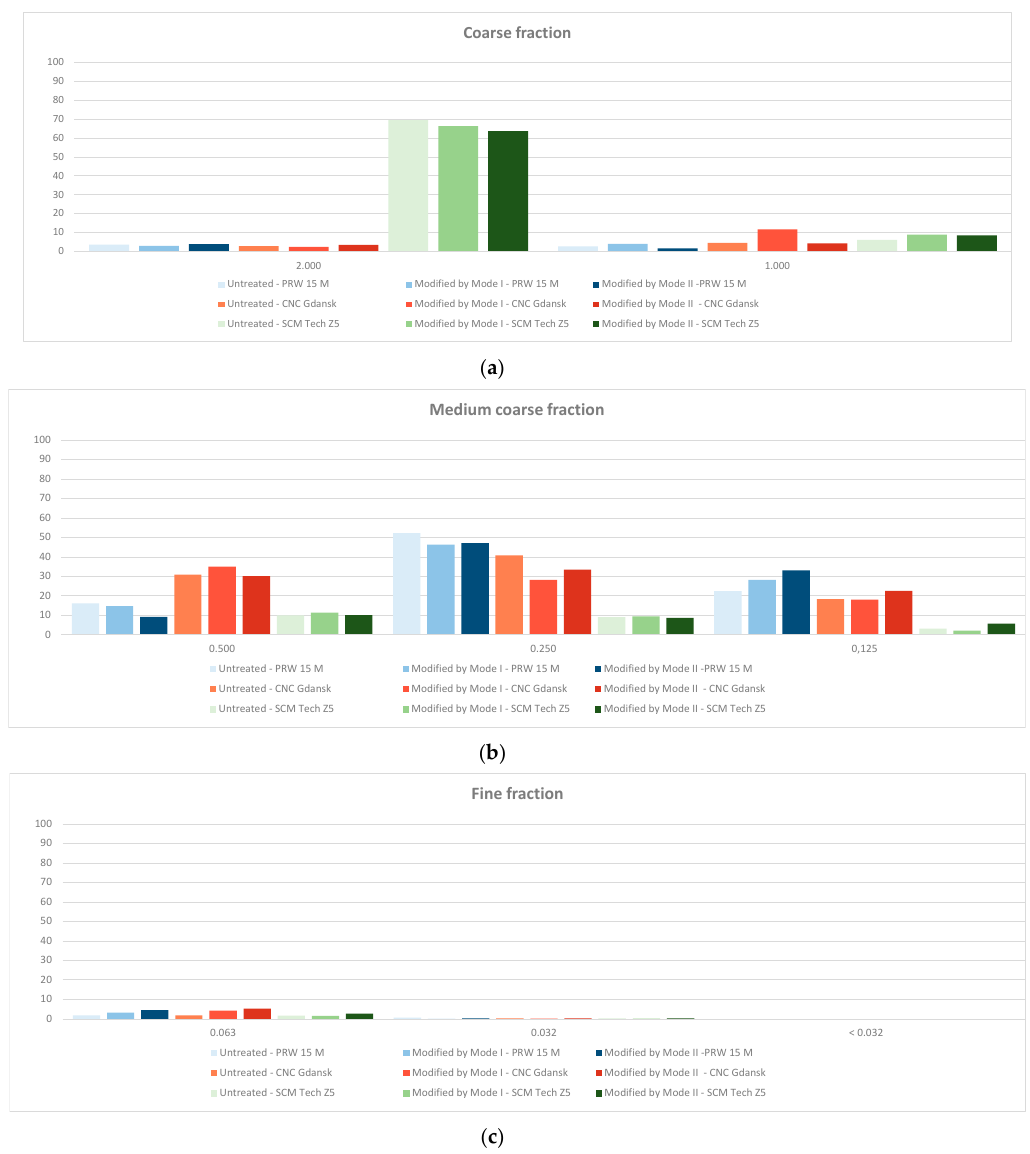
Figure 6. Comparison of sawdust and chips fractions from CNC machining centres ( a ) coarse fraction ( b ) medium coarse fraction ( c ) fine fraction.